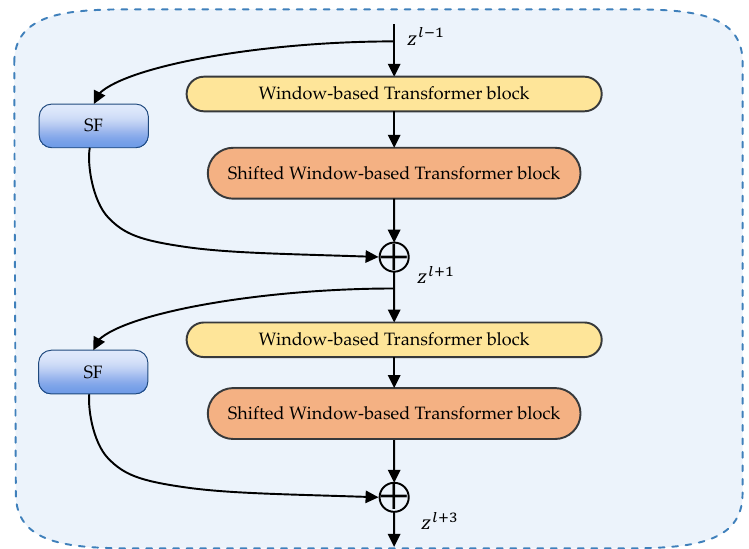
Figure 4. Swin Transformer blocks with the spatial fusion (SF)